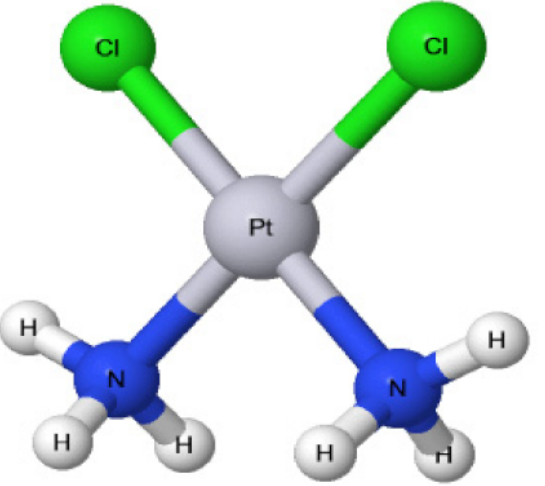
Figure 1. Chemical structure of cisplatin. Two neutral ammonia (NH 3 ) ligands and two chloride (Cl) anions are coordinated to the central platinum (Pt)